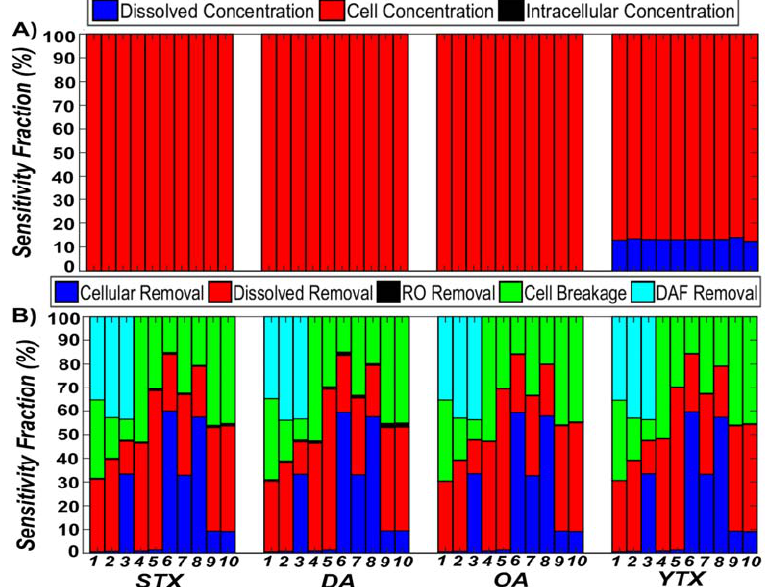
Figure 5. Sensitivity fractions of ( A ) model inputs, and ( B ) removal efficiency parameters as a function of algal toxin type and pretreatment processes (labeled as 1–10 for treatment train T1–T10 ).